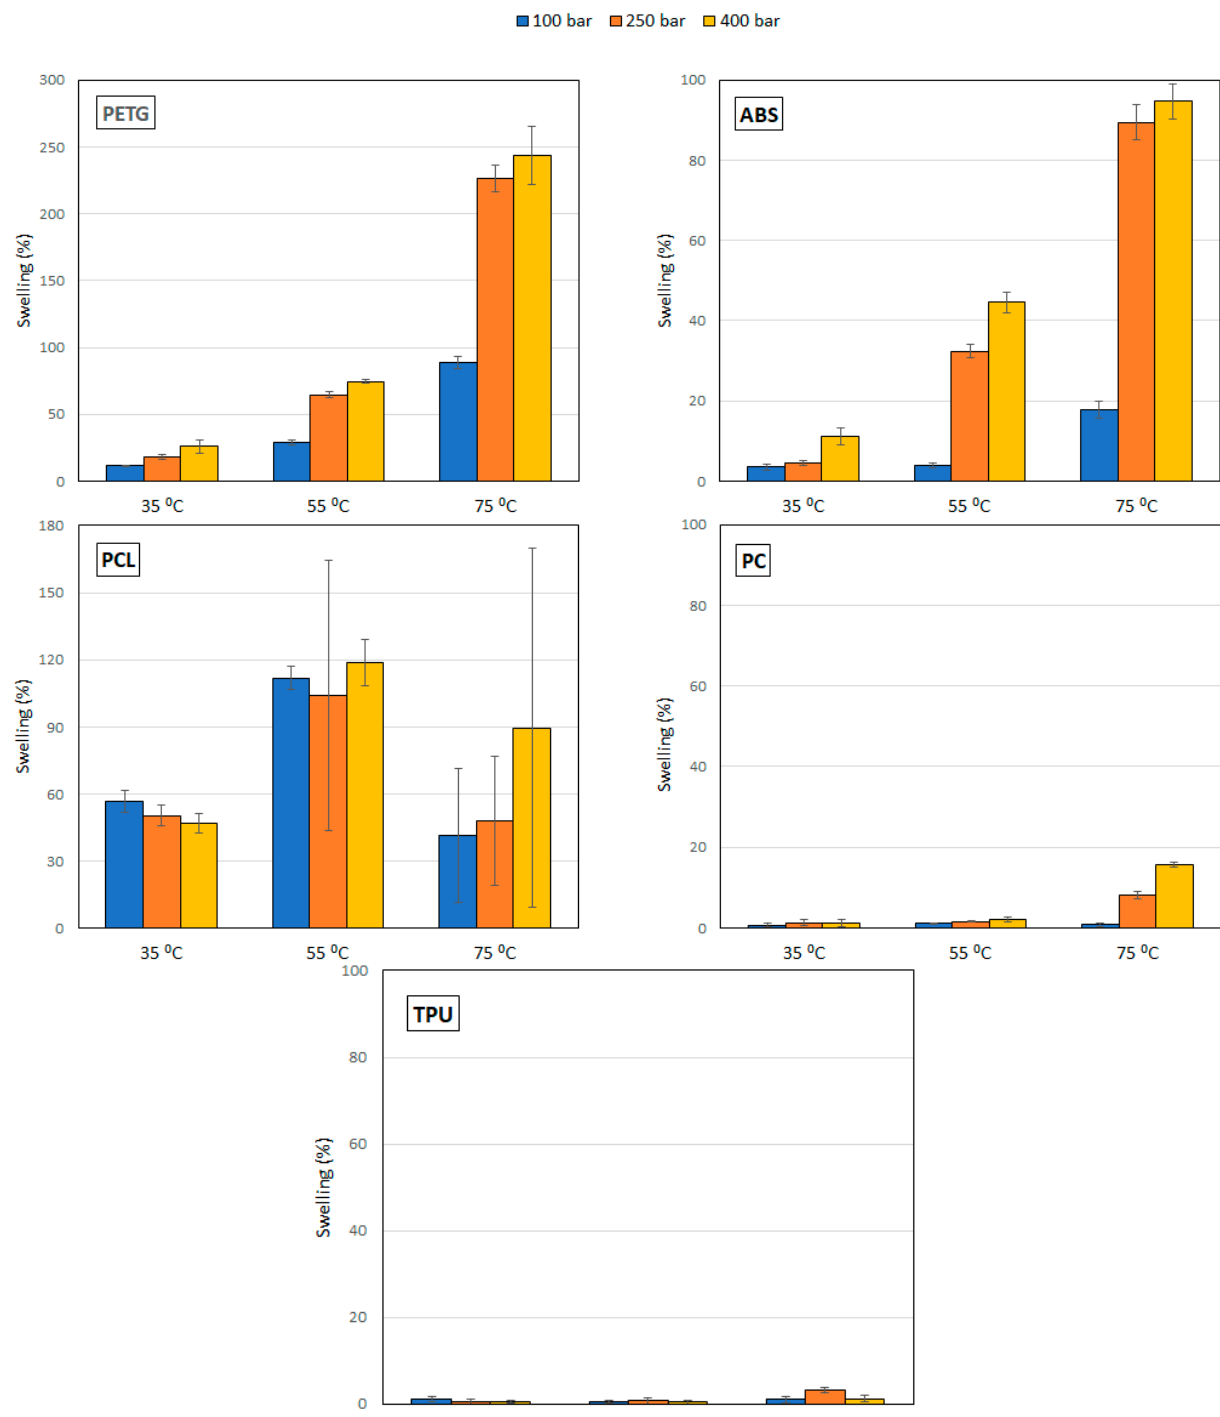
Figure 1. Swelling of the polymers under supercritical conditions of pressure and temperature.